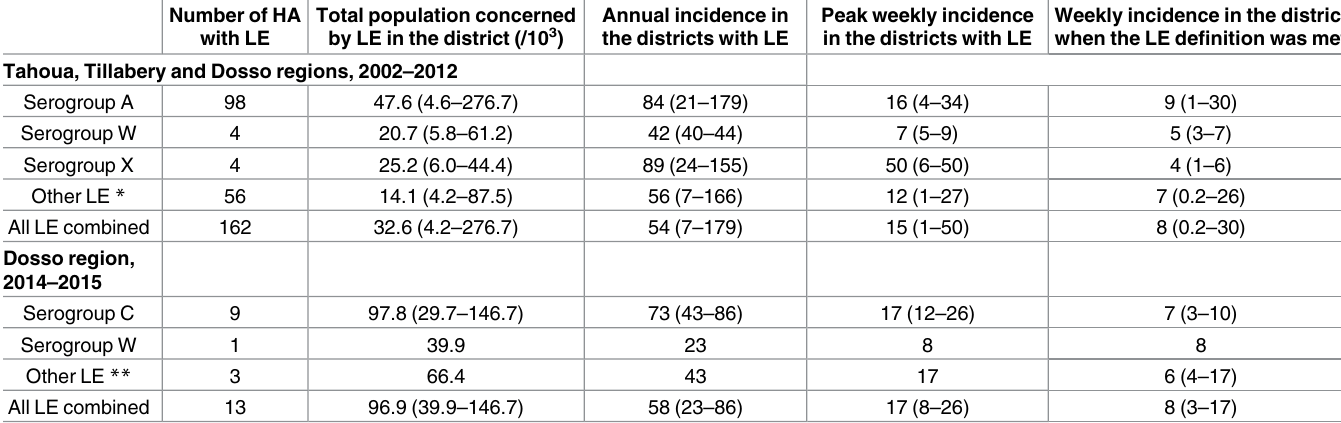
Chadawanka in Abalak district experiencedLEs four times: during 2002 (serogroup unknown), 2003 (NmA), 2005 (NmA and X) and 2006 (NmA). The LE did not follow any systematic spa- tiotemporal order of occurrence.During 2008 and 2009 (two years of particularly intensive incidence in Tahoua and Dosso regions), localized epidemics due to NmA showed positive Table 2. Visibility of meningitis localized epidemics (LE) in Niger at the district level, by epidemic agent in health areas (HA). Tahoua, Tillabery and Dosso regions, 2002–2012and Dosso region, July 2014-June 2015. Number of HA Total population concerned Annual incidence in Peak weekly incidence Weekly incidence in the district with LE by LE in the district (/10 3 ) the districts with LE in the districts with LE when the LE definition was